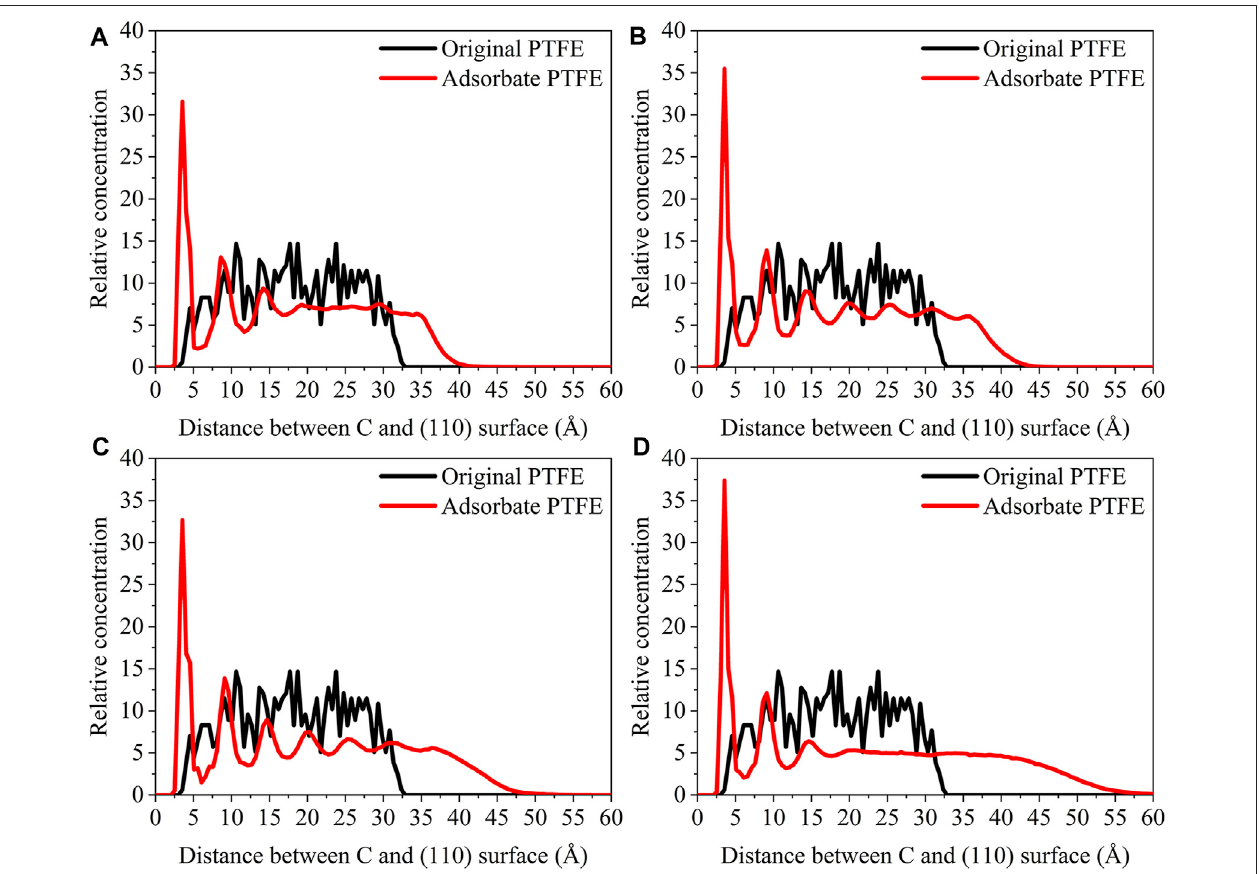
FIGURE 12 | Concentration distribution of C atoms along the z-axis for the (110)/PTFE interface system under different temperatures: (A) 25 ° C, (B) 100 ° C, (C) 200 ° C, and (D) 300 ° C.